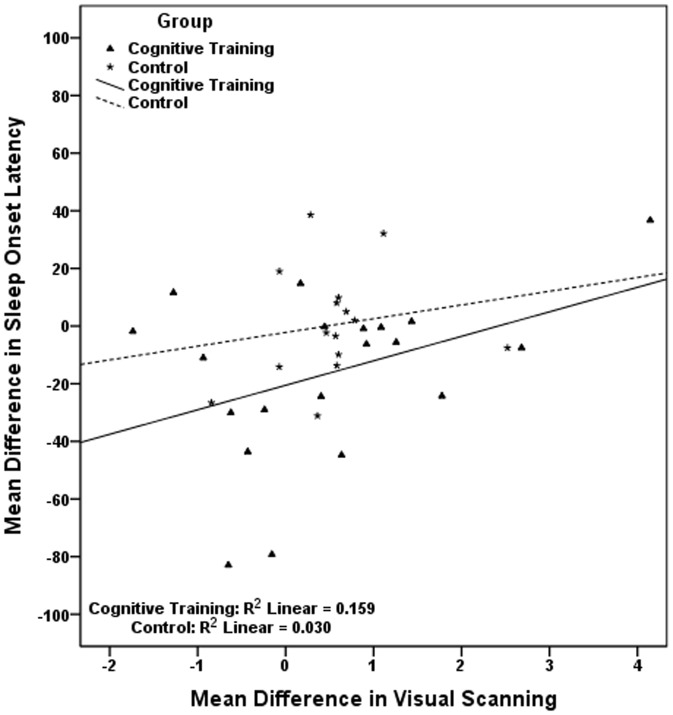
Linear regression between Mean Difference (post-intervention mean minus baseline mean) in Sleep Onset Latency (dependent) and Mean Difference (post-intervention mean minus baseline mean) in Visual Scanning (independent).